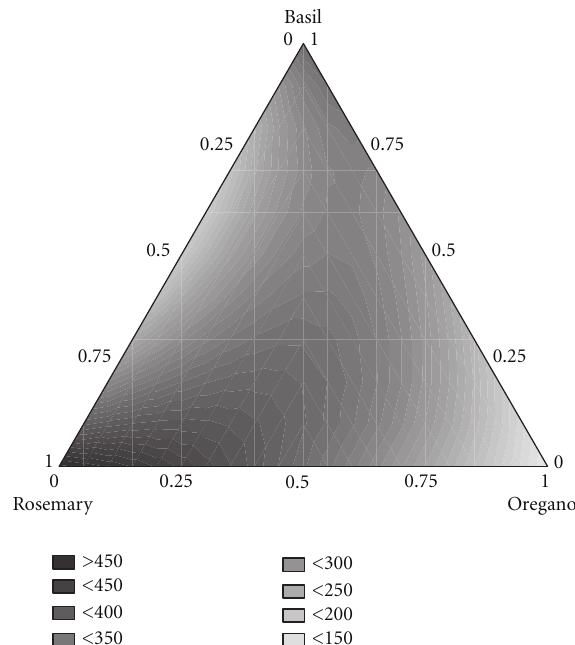
F 7: Response Surface for Storage Time determined by Rancimat method.